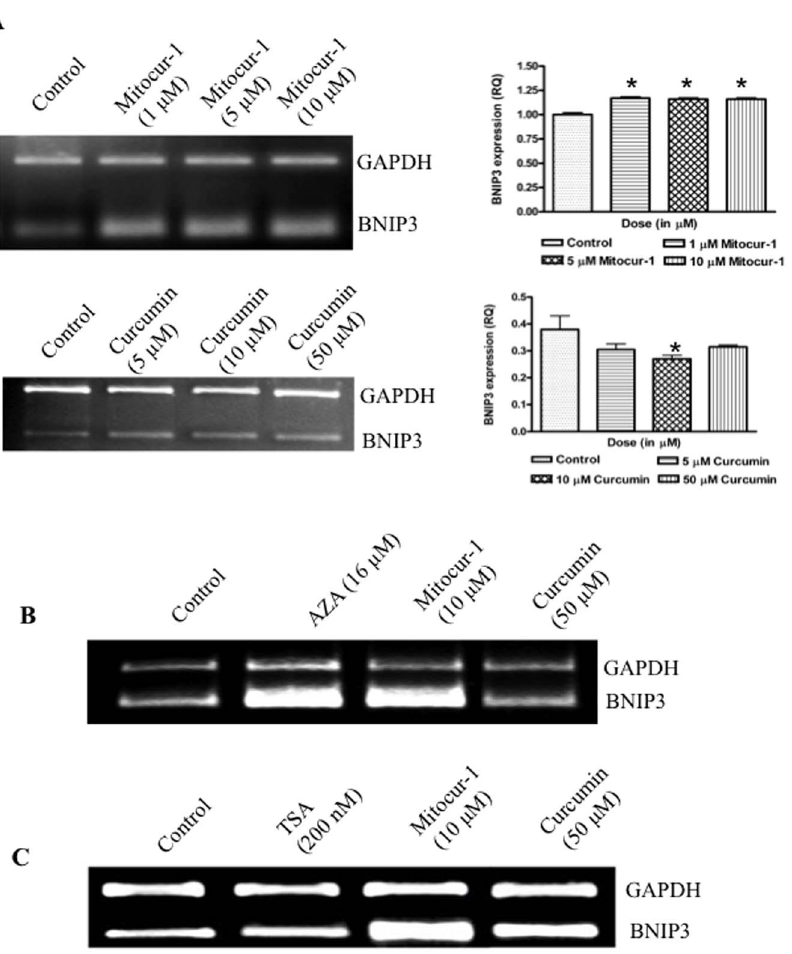
Figure 7. Curcumin and Mitocur-1 presumably regulates BNIP3 expression by modulating DNMT1 but not through HDAC’s. ( A ) MCF- 7 cells were treated with various concentrations of either mitocurcuminoid-1 (1–10 m M) or curcumin (5–50 m M) for a period of 24 h. Total RNA was extracted by TRIzol method and RT-PCR was performed using gene specific primers of BNIP3. ( B ) and ( C ) are same as A, except that cells were treated with AZA, (24 m M) or TSA (200 nM). Relative quantifications of BNIP3 expressions were presented in bar graphs. *, significantly different compared to control (p , 0.01).